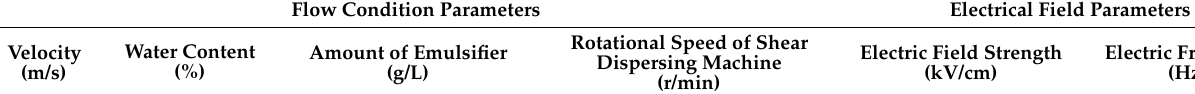
Figure 12. Average water droplet diameters.